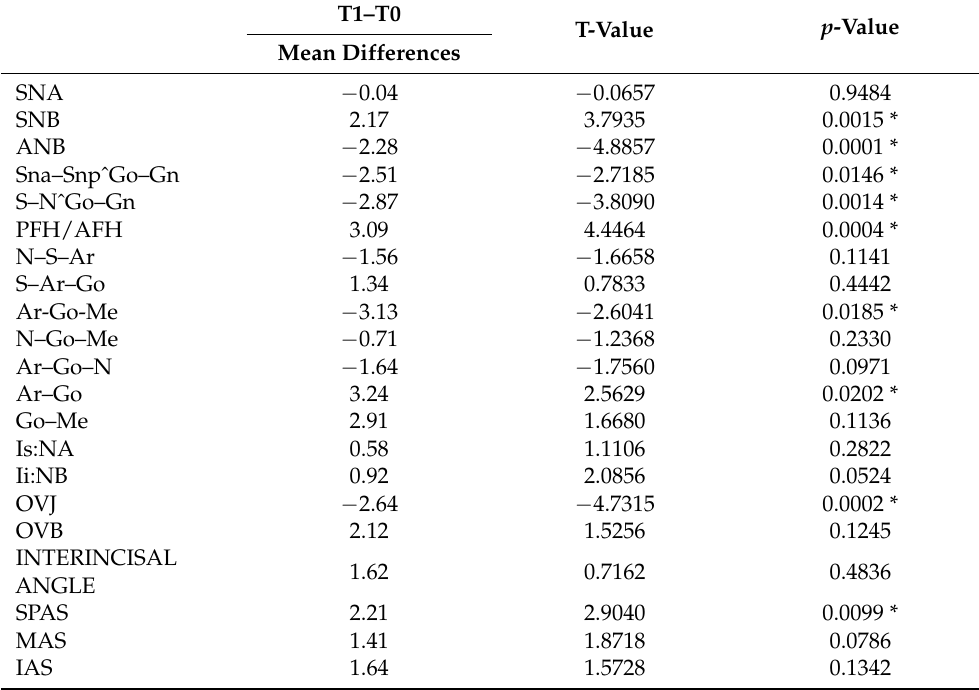
Table 2. Cephalometric measurements statistics.